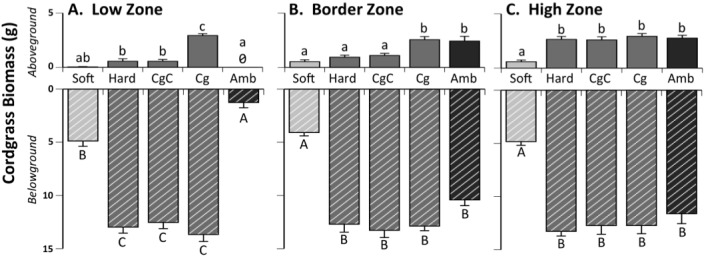
Above and belowground cordgrass biomass.Above and belowground cordgrass biomass harvested from exposed softened peat (Soft), exposed hard peat (Hard), procedural cage control (CgC), consumer exclusion cage (Cg) and ambient (Amb) treatments in the low (A), border (B), and high zones (C); all means are shown + SEM. Colors indicate initial differences in substrate hardness and letters indicate significant differences across treatments (Tukey’s HSD post hoc analysis with Bonferroni corrected P values).